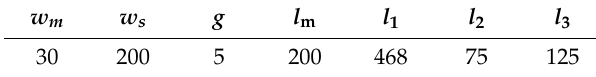
Figure 9. Fabricated microstrip-to-slotline transition: ( a ) top view; ( b ) bottom view. Table 3. Dimensions of the proposed transition (unit: mil).